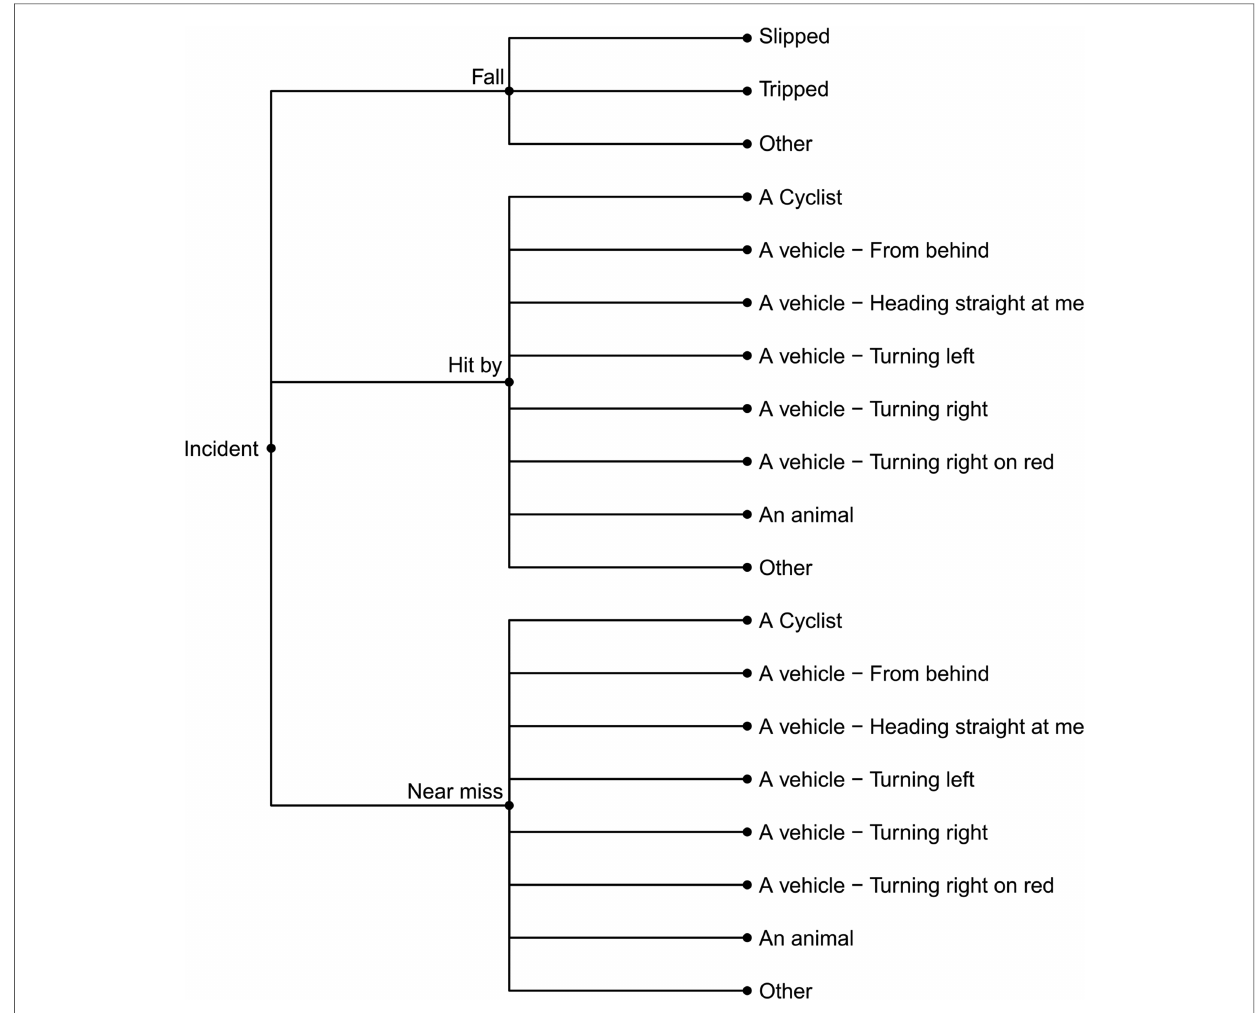
FIGURE 4 Choice of responses if participant chooses to report an